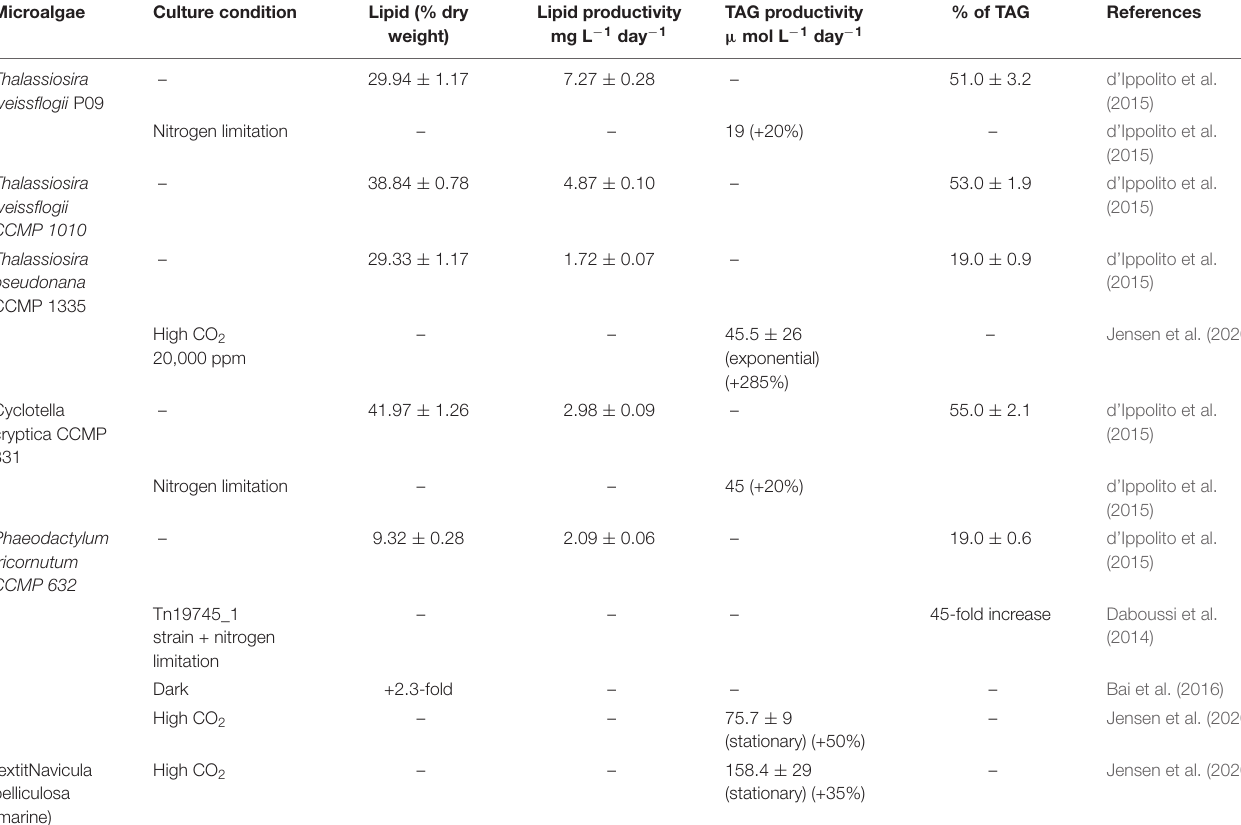
TABLE 1 | Lipid content and productivities of different microalgae diatom species (-: no data). Microalgae Culture